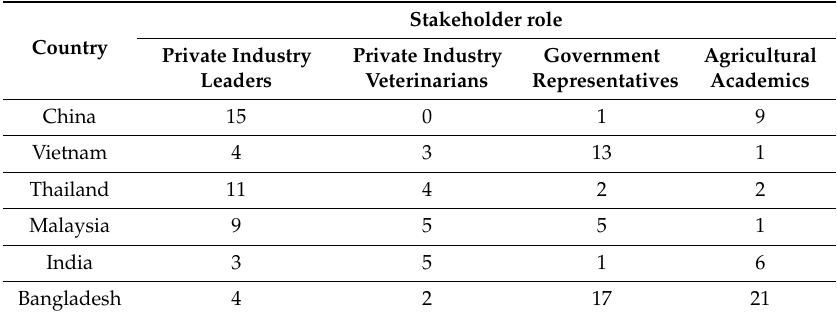
Table 2. Breakdown of stakeholder participant roles within the livestock industry, by